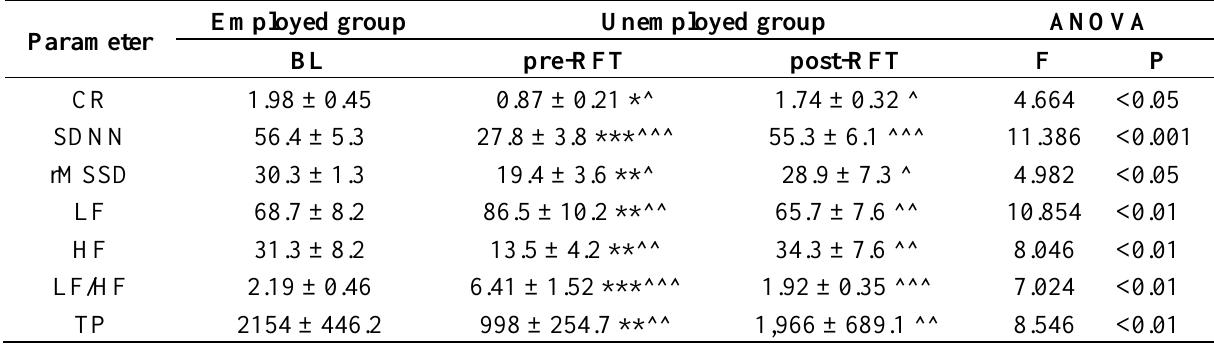
Table 5. Mean values and statistics of measured HRV and